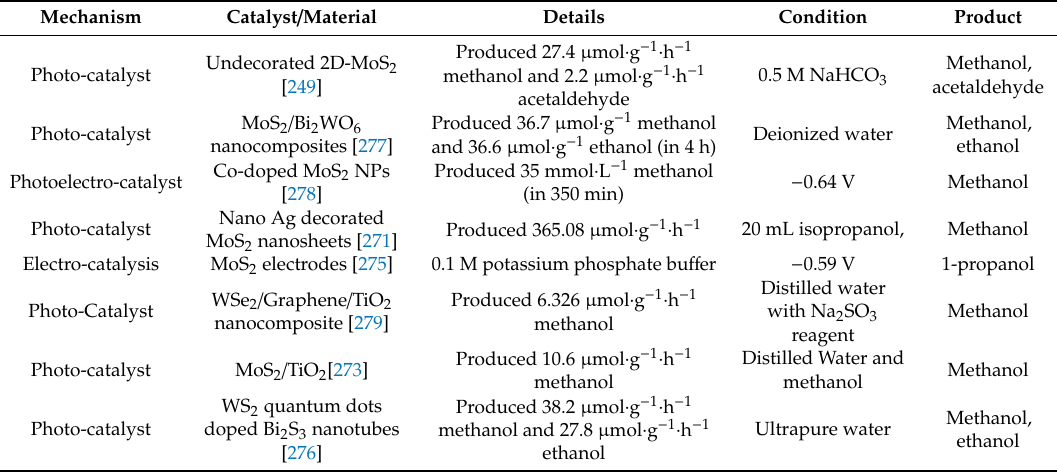
Table 5. Application of TMDCs in converting CO 2 to high-value